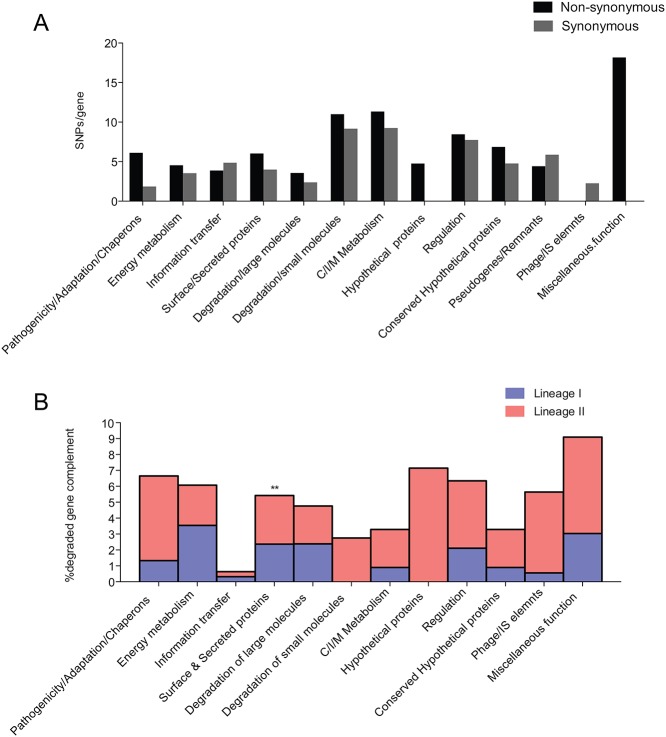
Functional characterisation of SNPs, pseudogenes and small indels in ST313 populations.A. Functional characterisation of non-synonymous (black bars) and synonymous (grey bars) of SNPs in lineages I and II. x-axis shows functional categories used for SNP characterisations; y-axis shows proportion of mutated genes (%) to the no of genes belonging to the functional categories. B. Functional characterisation of degraded gene complement (pseudogenes and deletions) in lineage I (blue bars) and lineage II (red bars). x-axis represents % proportion of pseudogenes in each functional group. Asterisks indicate significantly over-represented group with p < 0.05 using a two-way ANOVA with post-tests performed using the Bonferroni method.